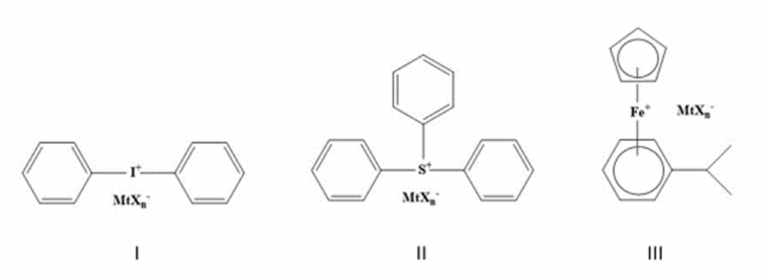
Figure 2. Structures of most common cationic photoinitiators.